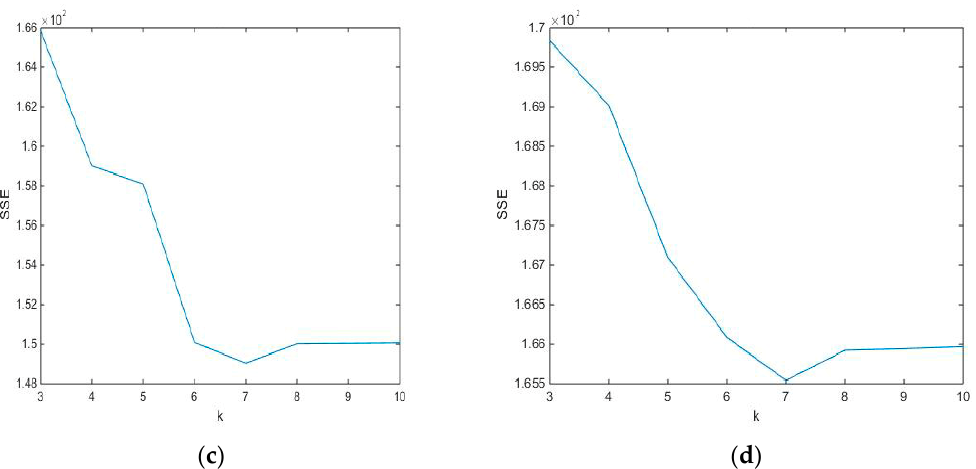
Figure 13. Sum of squares due to error (SSE) curve of K-Means algorithm from 4 universities: ( a ) S1; ( b ) S2; ( c ) S3; and ( d ) S4.